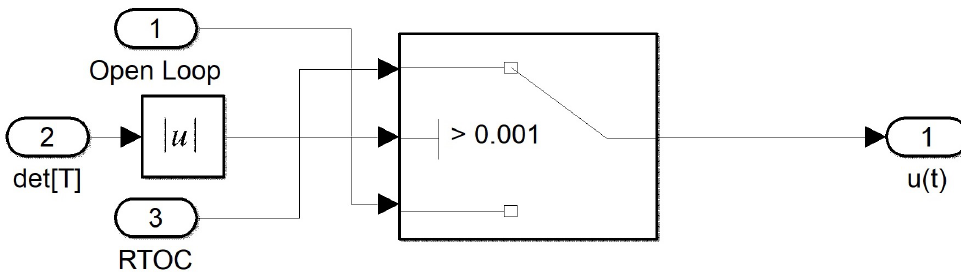
Figure A5. Real-time optimal control Simulink model.